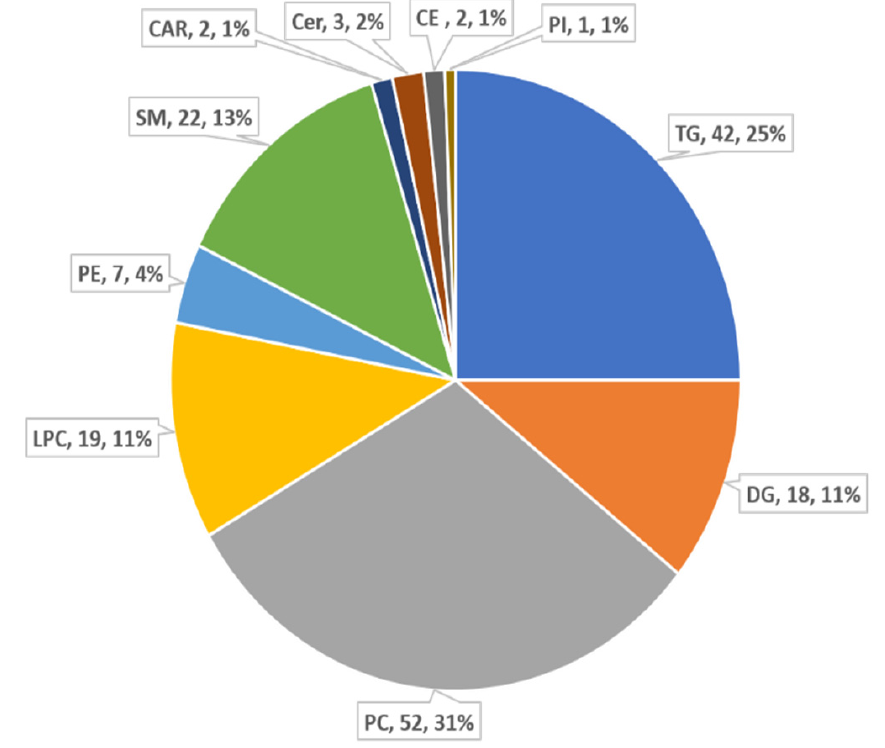
Figure 1. Composition of lipid classes that were considered for subsequent analysis in samples detected by LC-MS.